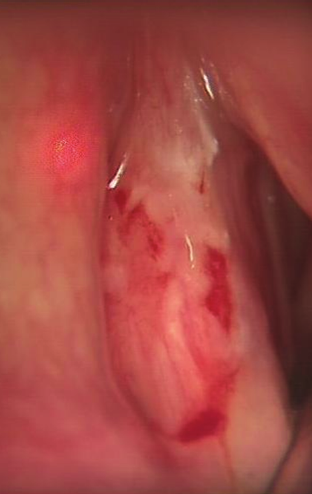
Figure 1: Left sided T1aN0M0 vocal cord carcinoma under surgical microscope.